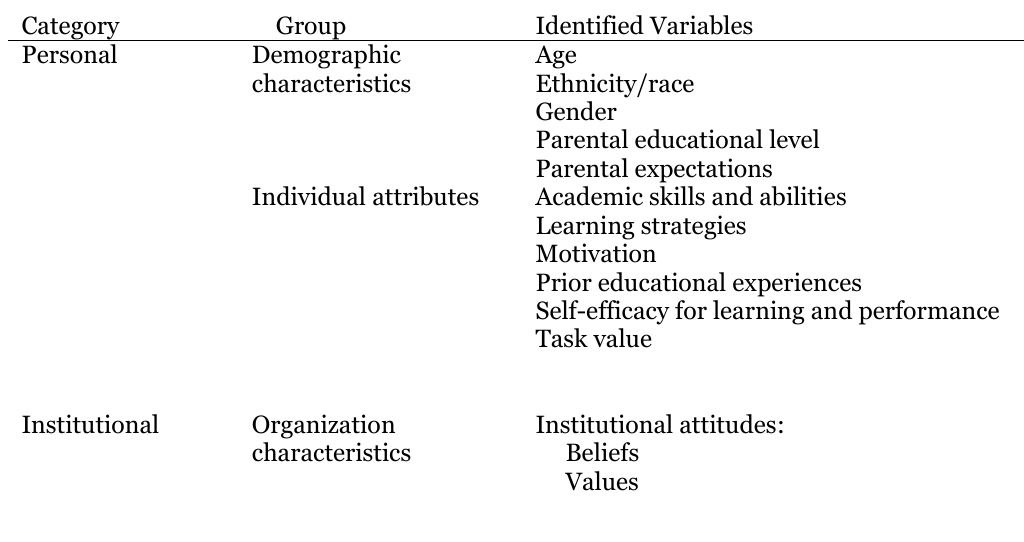
Table 1 Range of Variables Affecting Retention